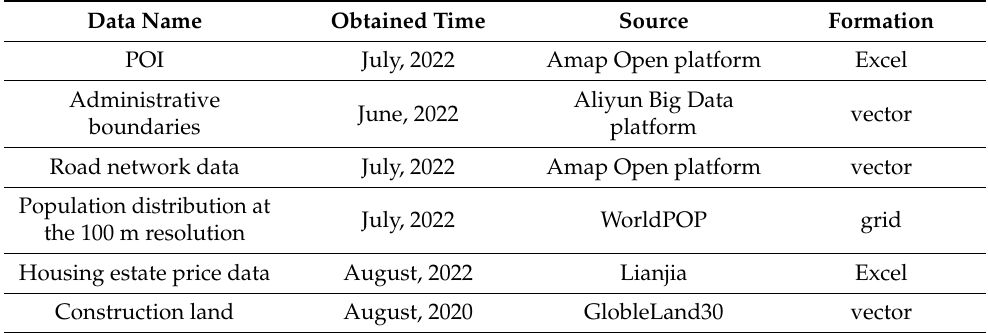
Table 1. Data source